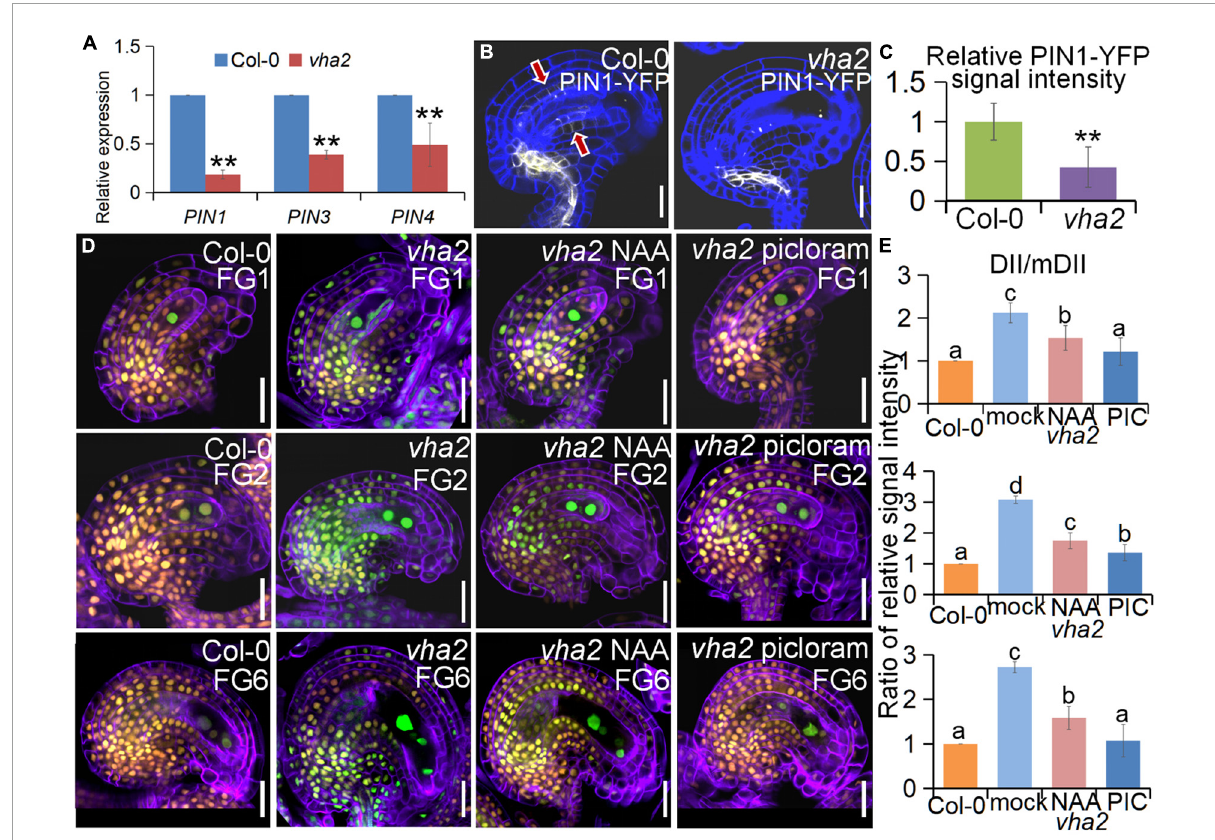
FIGURE6 Lack of V-ATPase affects polar auxin transport and auxin distribution. (A) Relative transcript levels of PIN1, PIN3, and PIN4 in inflorescence apices of Col-0 and vha2. Bars correspond to arithmetic means ± SE of three technical replicates of three biological replicates. Asterisks indicate significant difference (Studert’s tw0-tailed t -test: ** P < 0.01). (B) PIN1-YFP express ion in Col-0 and vha2 ovules. Bars = 20 µ m. Graphs represent typical phenotype of all samples. (C) Quantitative analysis of PIN1-YFP fluorescence level in ovules. Bars correspond to relative YFP signal intensity. Relative fluorescence signal data were extracted from normalized mean gray levels in the above lines. Values correspond to arithmetic means ± SE of three biological replicates ( n = 20). Asterisks indicate significant difference (Student’s two-tailed t -test: ** P < 0.01). (D) R2D2 expression in Col-0 and vha2 ovules under picloram and NAA treatment during FG development. (orange for mDII-tdTomato and green for DII-Venus). Cell walls were stained with FB28 (purple). Bars = 20 µ m. Graphs represent the typical phenotype of all samples. (E) Quantification of fluorescent signals of R2D2 (DII/mDII). Relative fluorescence signal data were extracted from normalized mean gray levels in the above lines. Values correspond to arithmetic means ± SE of three biological replicates ( n = 20). Lowercase letters indicate statistically significant differences between different stages ( P < 0.05). 10 ovules shown in the statistical graph come from 3 different inflorescence